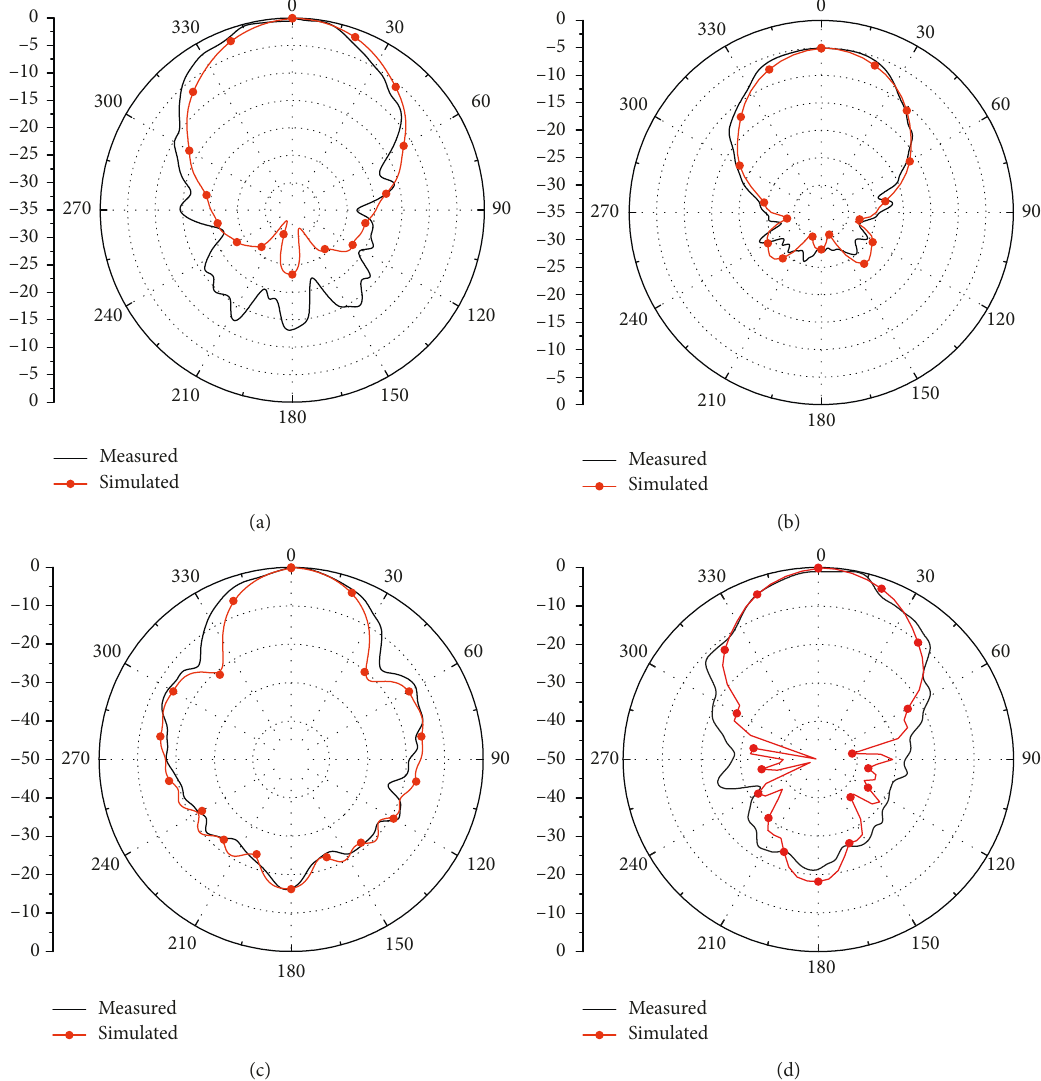
Figure 7: Microwave horn filtenna radiation pattern. (a) E -plane at 2.56GHz. (b) H -plane at 2.56 GHz. (c) E -plane at 3.50GHz. (d) H -plane at 3.50GHz.